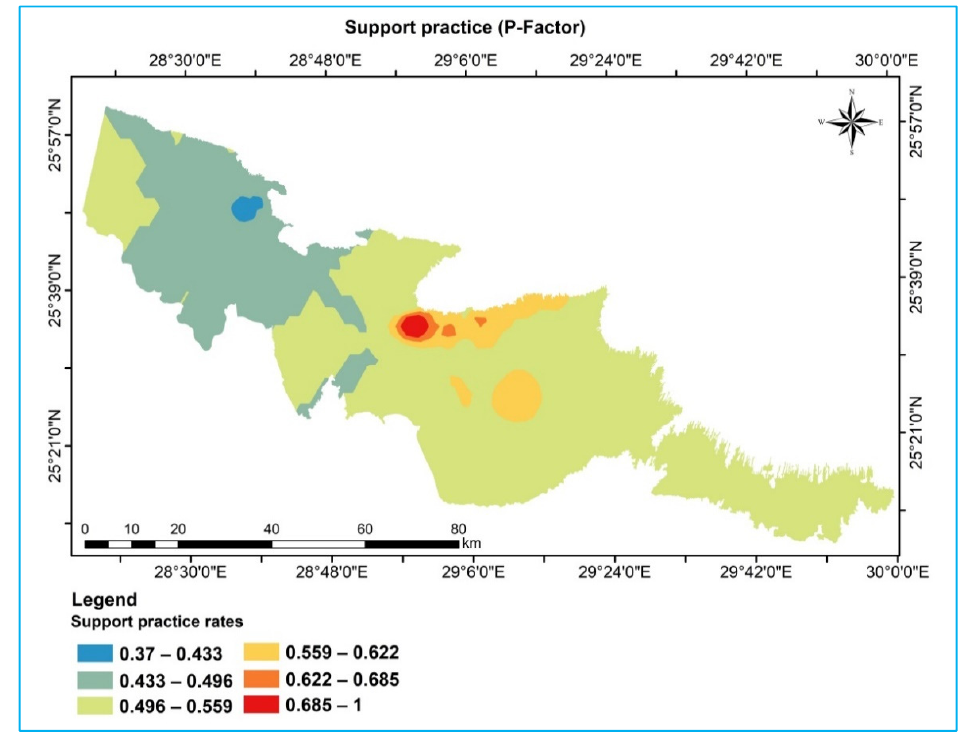
Figure 11. Spatial distribution map of conservation practice factor (P-Factor).